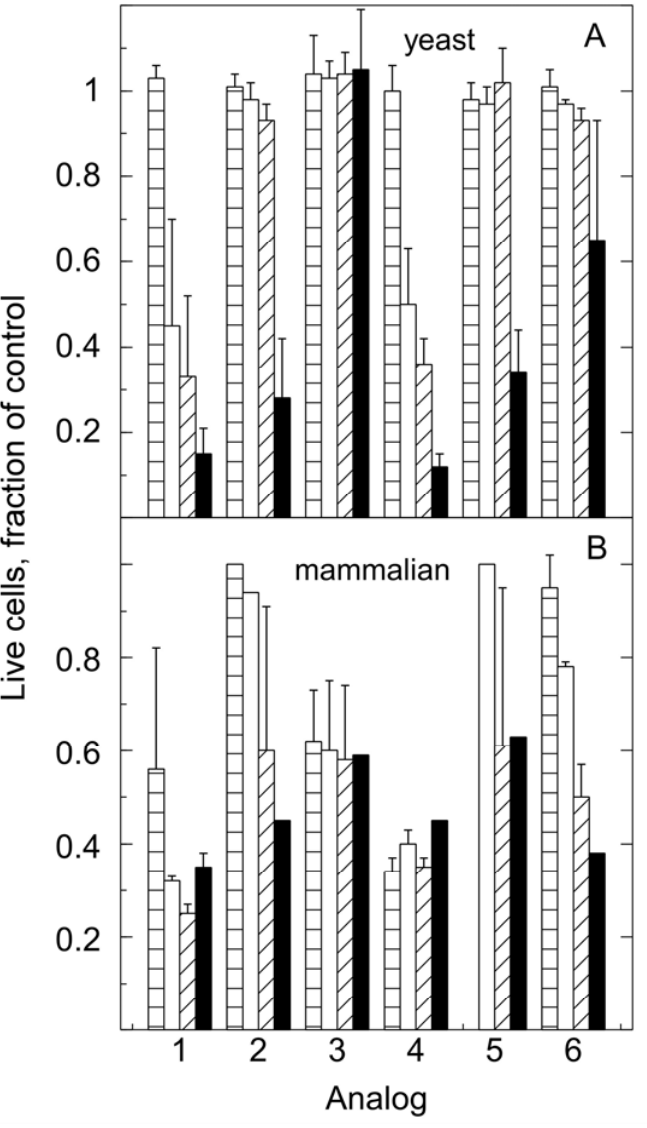
Figure 4. Comparison of toxicity of MG analogs for yeast and human cells. All cell numbers are expressed as fractions of the DMSO control. Bars: 0.1 μ M (parallel slash), 0.5 μ M (white), 1 μ M (45° slash), 5 μ M (black). The error bars show standard deviations. Each yeast point is the average of 3 independent sets of experiments. The mammalian data is the average of two to three experiments with triplicate independent estimates in each experiment. Error bars are only shown where the values for more than one experiment have been